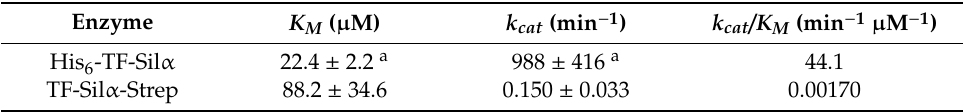
Table 6. Michaelis-Menten constants for the hydrolysis of TBDMS-ONp catalysed by His 6 -TF-Sil α and TF-Sil α -Strep. The errors represent standard